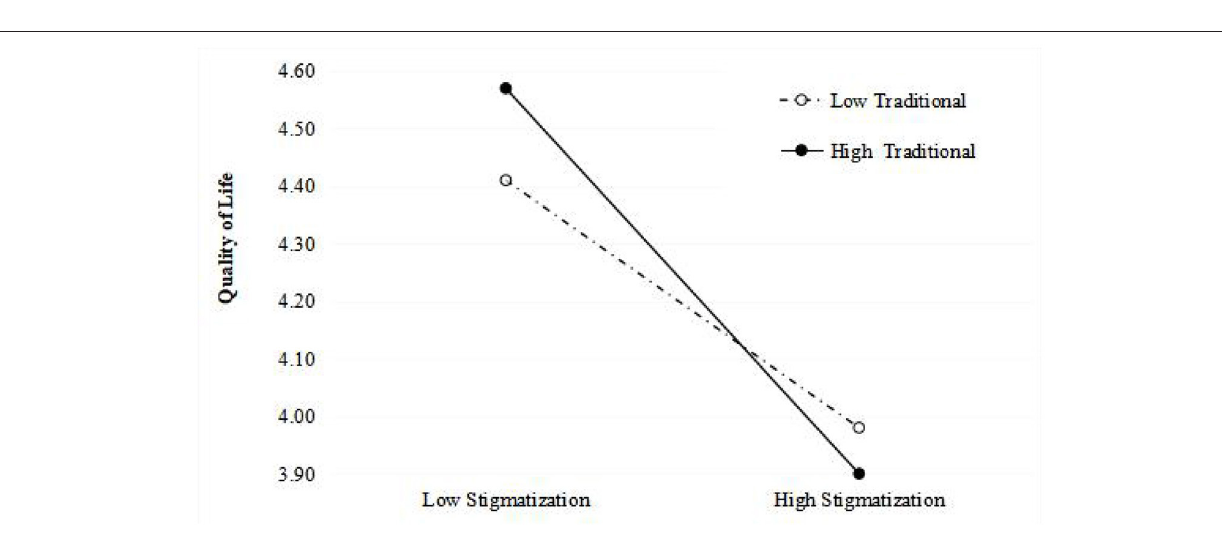
FIGURE 2 | Simple slope diagram of the influence of the interaction between self-perceived stigma and traditionality on the quality of